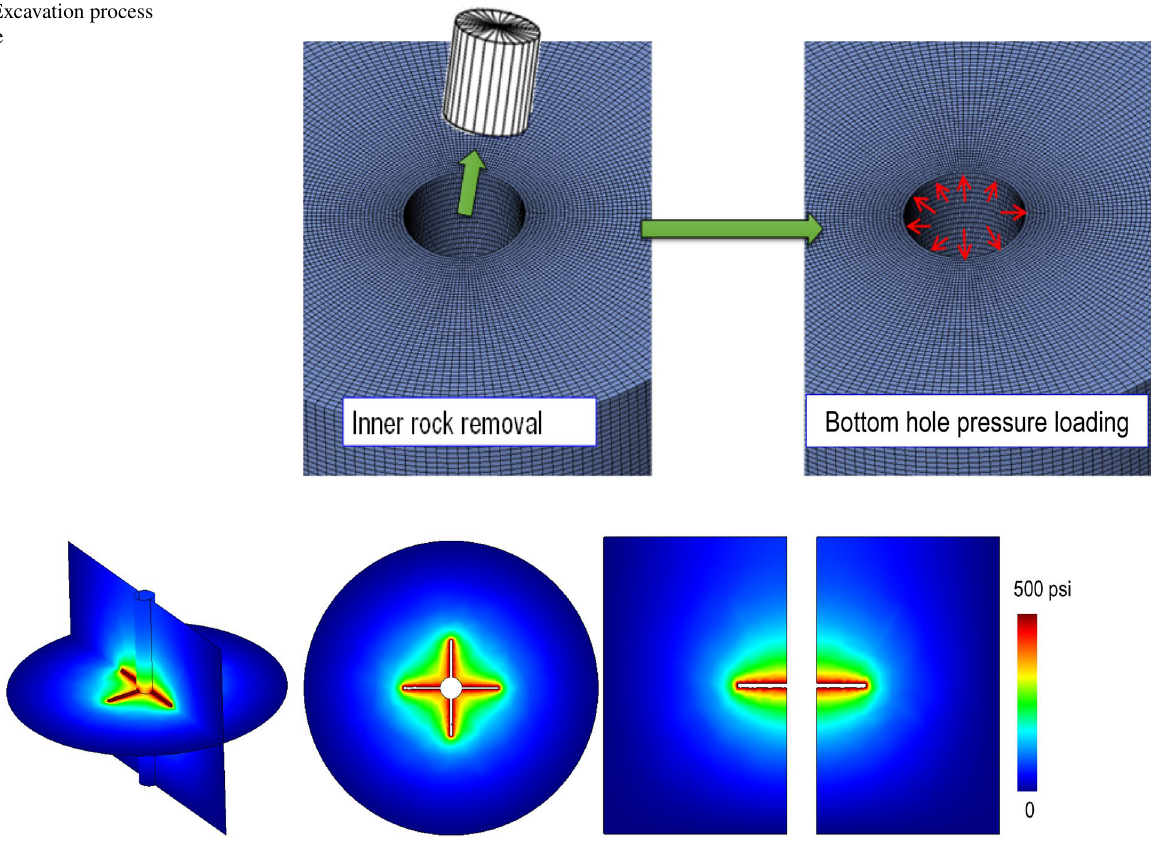
Fig. 22 Distribution of pore pressure change (psi): 3D view (left); top view (middle); vertical cross-section (right)